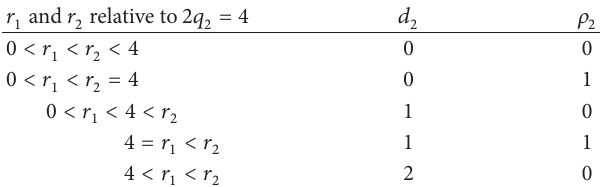
Table 2: 𝑑 𝑖 and 𝜌 𝑖 for 𝑖 = 2